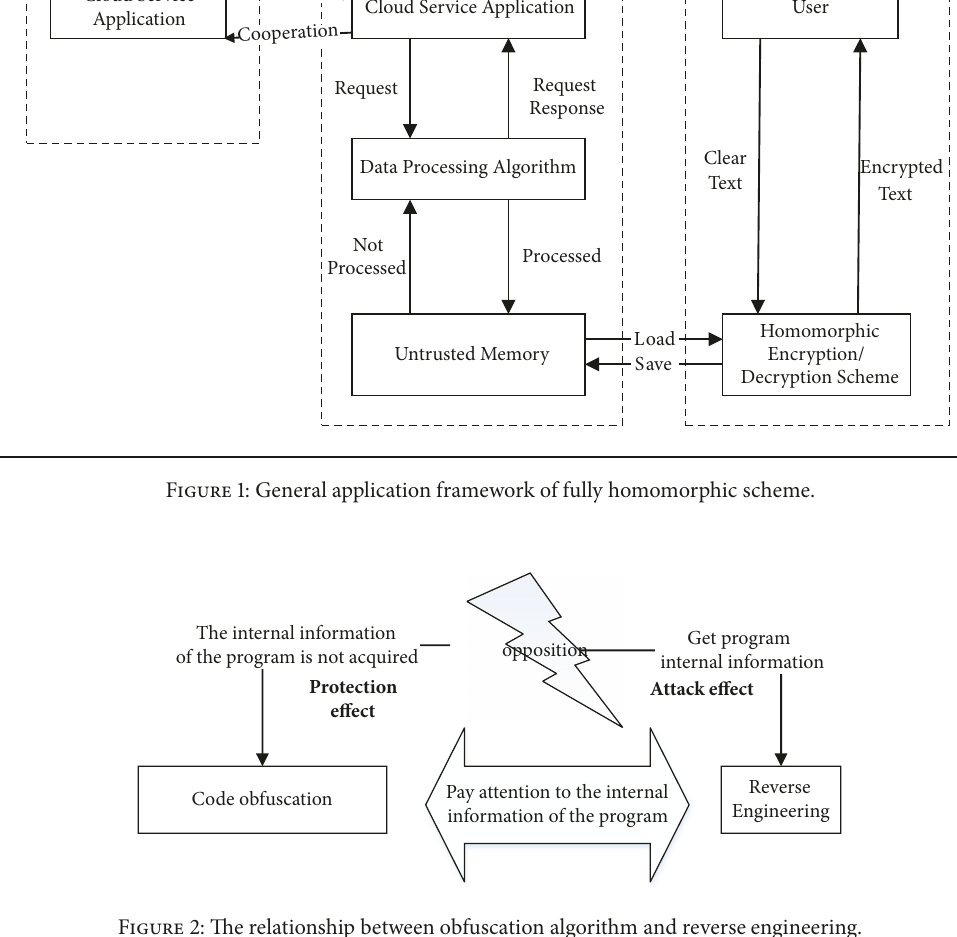
Figure 2: The relationship between obfuscation algorithm and reverse